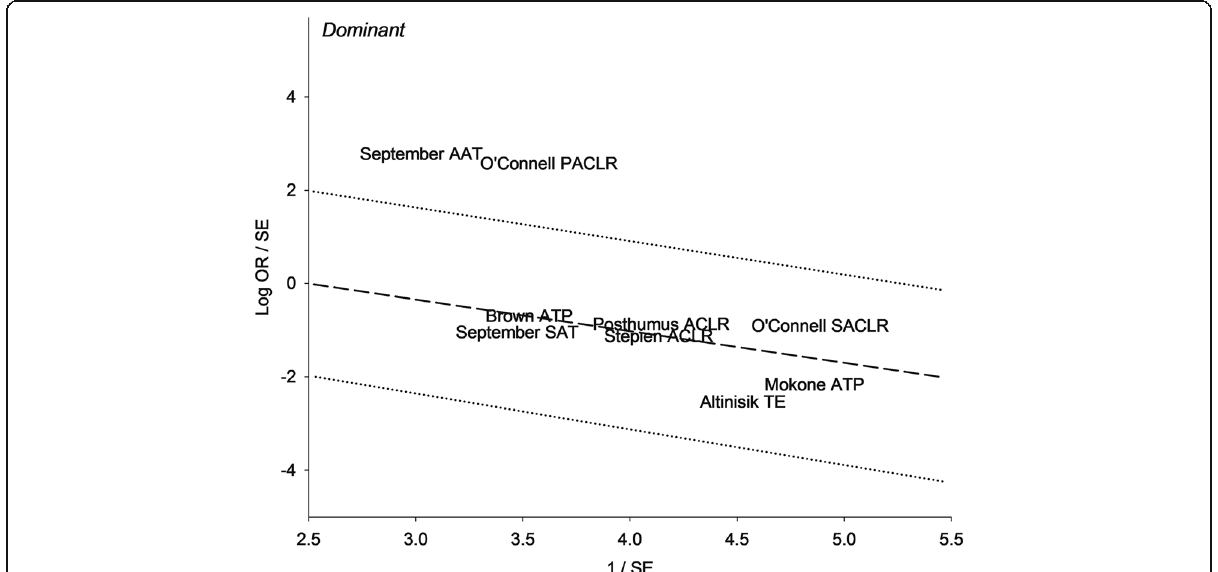
Fig. 3 Galbraith plot analysis of COL5A1 rs12722 polymorphism in the dominant model. The two studies found above the + 2 confidence limit are identified as outliers. OR, odds ratio; SE, standard error; AAT, Australia Achilles Tendinopathy; PACLR, Poland Anterior Cruciate Ligament Rupture; SAT, South Africa Achilles Tendinopathy; SACLR, South Africa Anterior Cruciate Ligament Rupture; ATP, Achilles Tendinopathy;